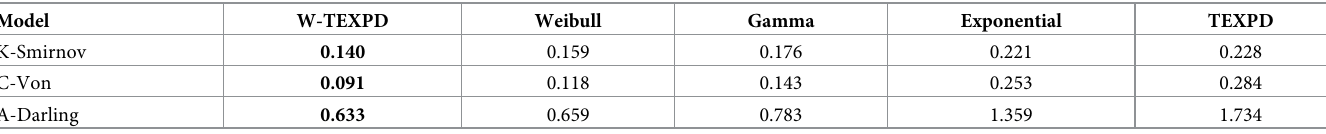
Table 7. Goodness of fit statistic of failure time of 50 components (per 1000 hours). Model